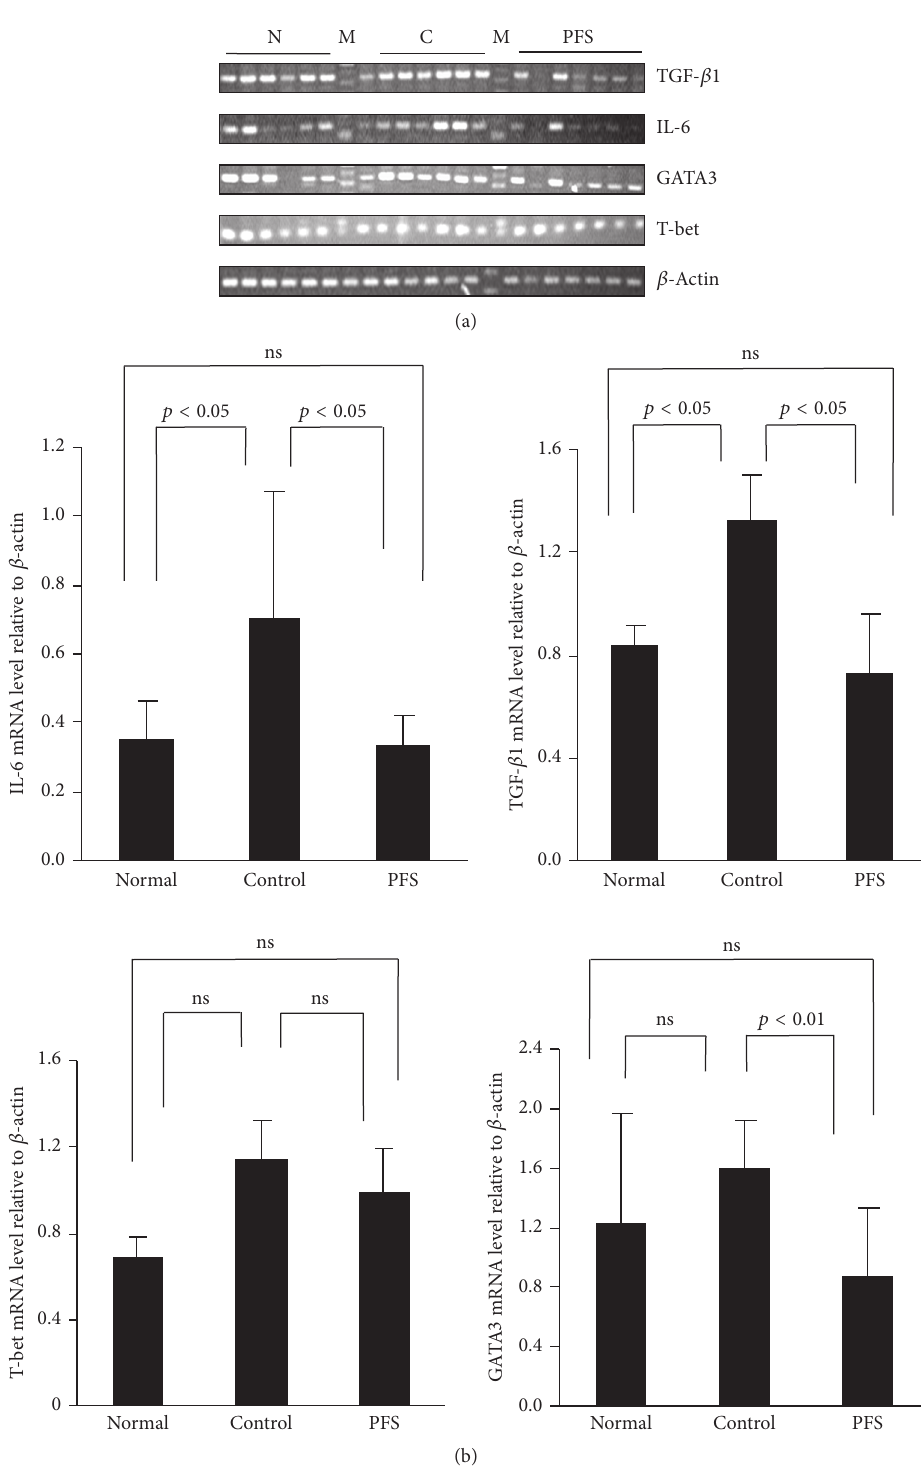
Figure 2: PFS suppressed the expression of inflammatory cytokines. AIA was induced as detailed in Methods. Arthritic rats were treated with 50 mg/kgPFSfor35days.Day28:splenocyteswereharvestedformeasuringcytokineexpressionbyquantitativeRT-PCR.(a)RT-PCRanalysis of inflammatory cytokine genes and related transcription factors and (b) relative amounts of each cytokine gene level were determined by densitometric analysis. Dunnett’s test. N: normal; C: control; M: marker. ns: no significant